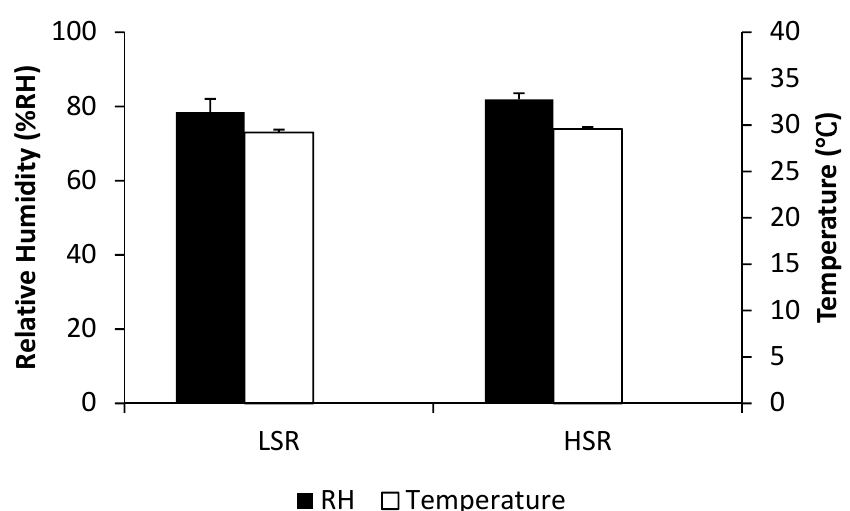
Figure 6. Comparison of body-seat interface relative humidity (RH) when the sensor moves towards the left mid-thigh of the participant at two different velocities: lower speed rate (LSR; 0.17 cm/s ± 0.01 cm/s) and higher speed rate (HSR; 0.32 cm/s ± 0.01 cm/s). In addition, the temperature values at the contact surface for different speeds of sensor movement are illustrated along with RH. Error bars denote ±1 standard deviation. To analyse the relationship between the sensor approach speeds and RH, the average values of each trial for sensor speed and its relative RH were assessed for the presence of a correlation. However, no correlation was observed between high speed and RH, whereas at best a weak correlation might exist with slow speed (correlation coefficients 0.02 and 0.64, respectively). In addition, the trend curve for both moisture and temperature showed an apparent “spike” after the sensor achieved full contact with the left mid-thigh of the participant (Figure 7).